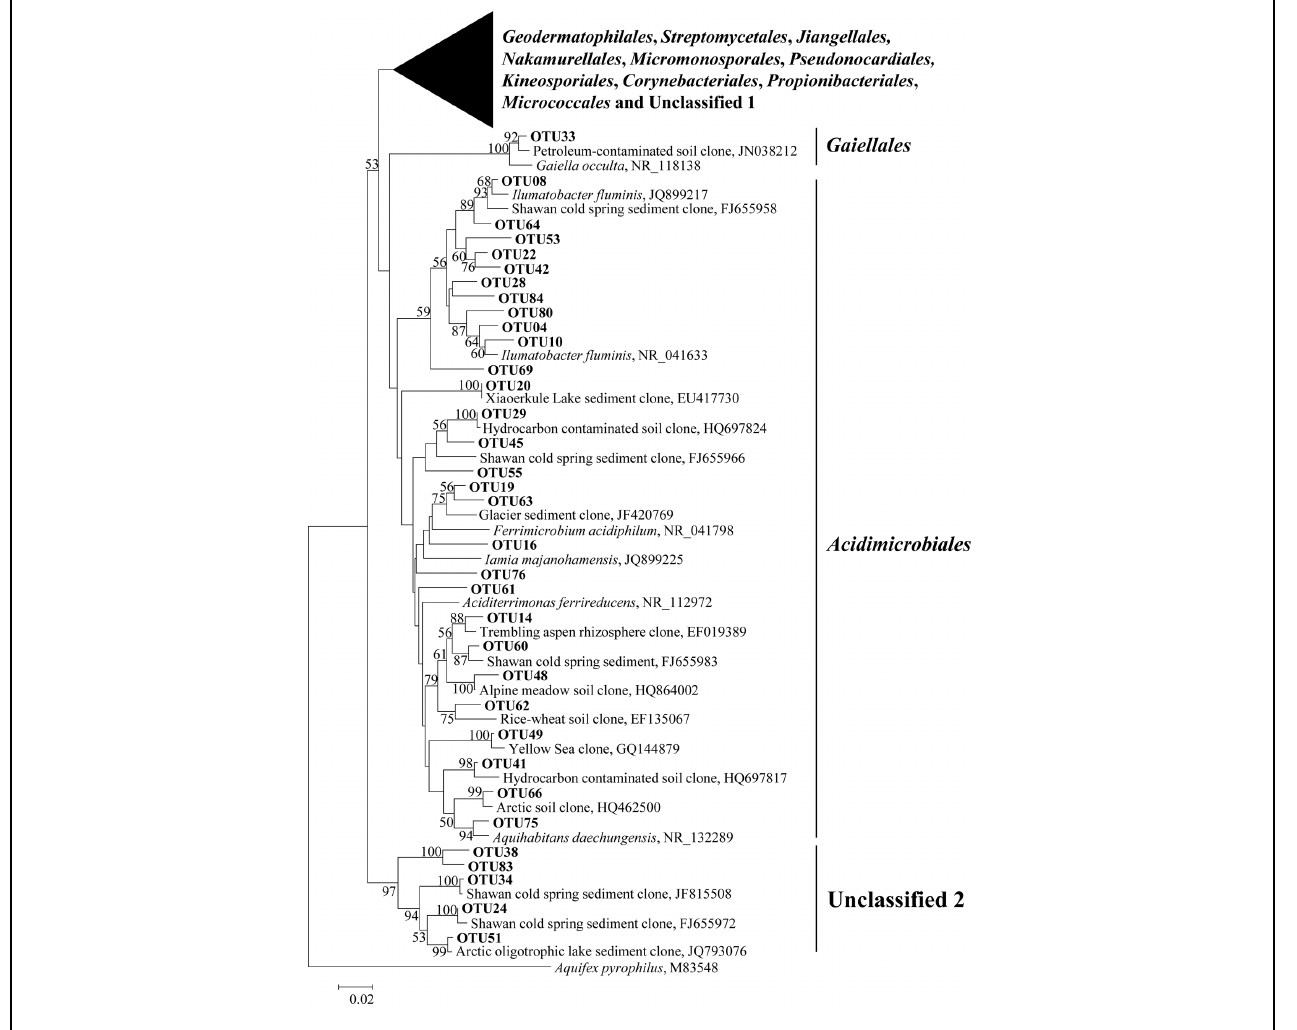
FIGURE 2 | Continued Maximum-likelihood tree (partial sequences, ∼ 640 bp) showing the phylogenetic relationships of the actinobacterial 16S rRNA gene sequences cloned from the studied samples to closely related sequences from the GenBank database. One representative clone sequence within each OTU was shown. Bootstrap values of > 50% (for 1000 iterations) were